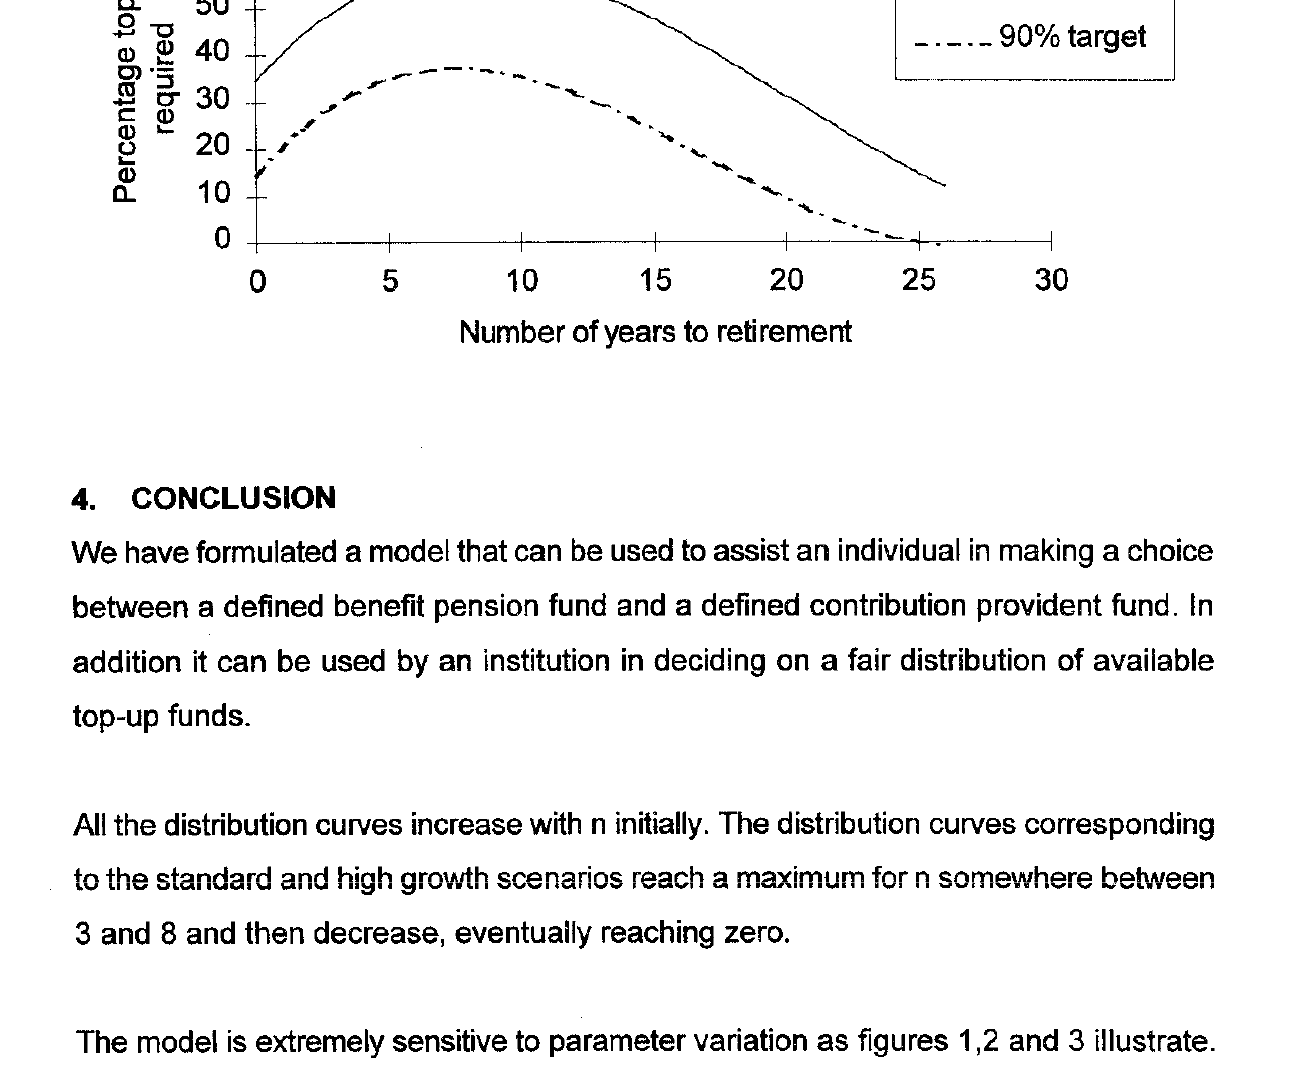
Figure 6: Targeting a percentage of the AIPF